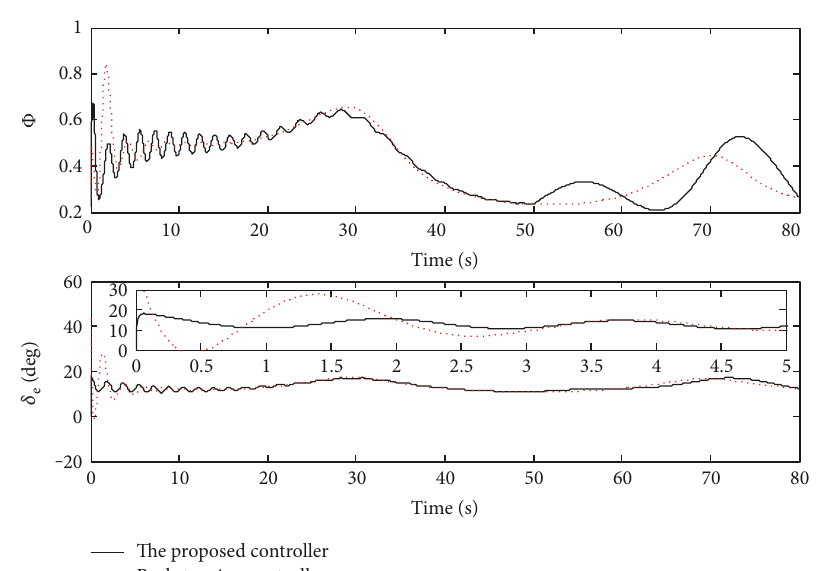
Figure 5: The control